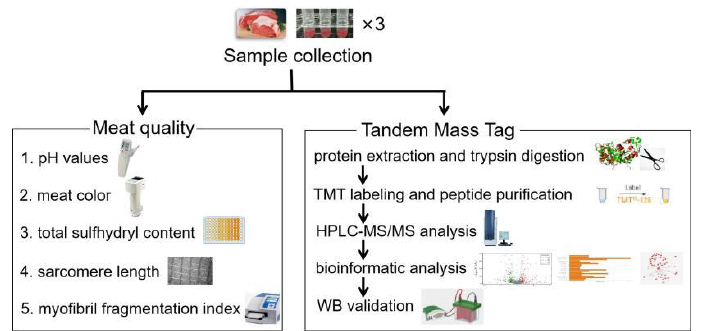
Figure 1. Experimental design and workflow. TMT: tandem mass tags, HPLC-MS/MS: liquid-chromatography tandem mass spectrometry, WB: western blot.